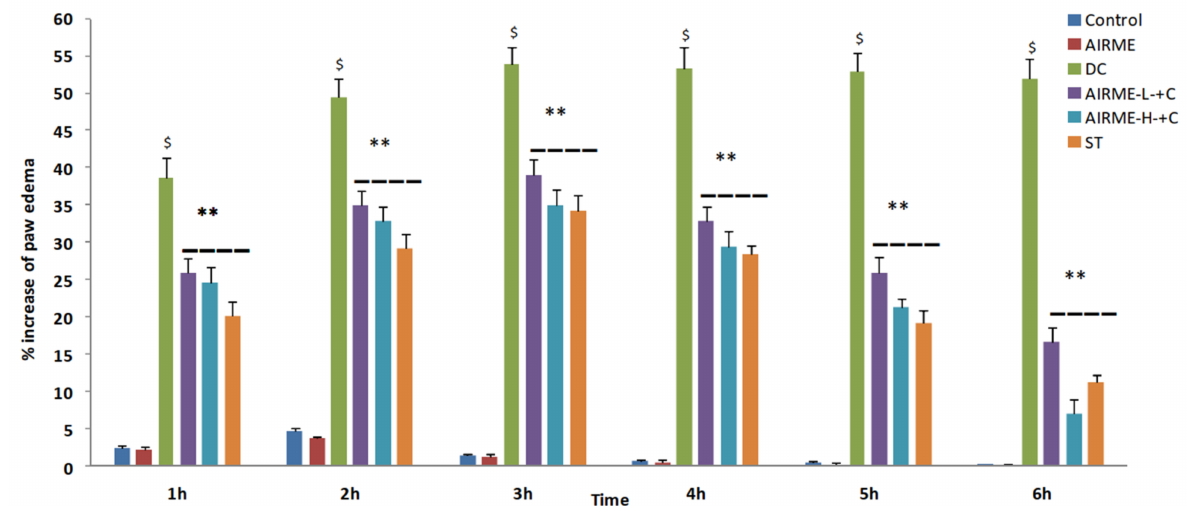
Figure 1. Percent changes in paw volume during the time course of 6 h after carrageenan injection (acute inflamma- tion) in control and AIRME pretreated groups. Values are significant compared with control ($ p < 0.05) and com- pared with carrageenan-injected group (** p < 0.01). NC, normal control; DC, disease control; AIRME, A. indica root methanolic extract; AIRME-L+C, AIRME-low-dose plus carrageenan; AIRME-H+C, AIRME-high-dose plus carrageenan; ST, standard